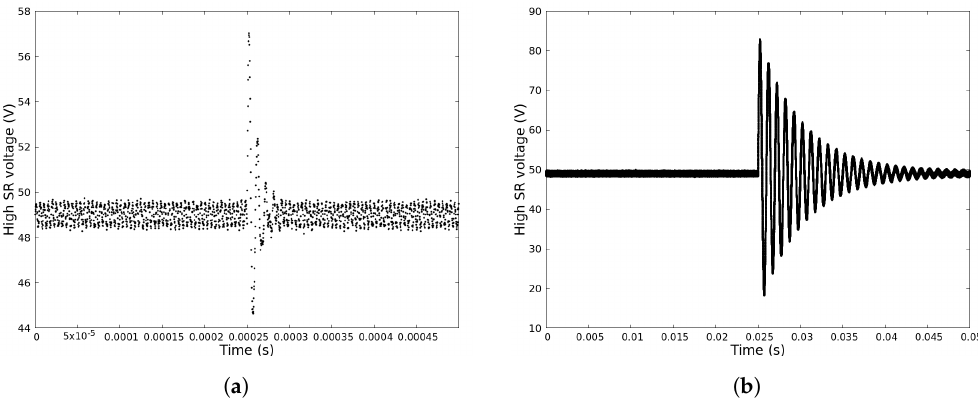
Figure 5. Capture of synthetic oscillatory transients: quick ( a ) and slow oscillations ( b